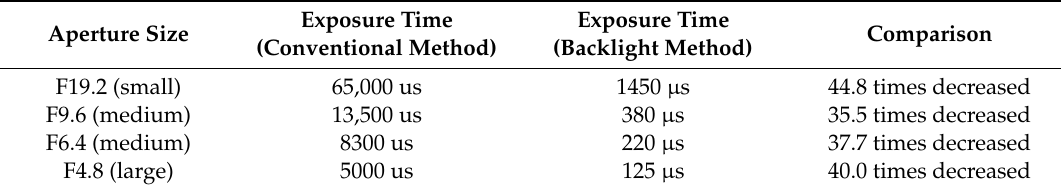
Figure 4. Experimental setup of enhanced t -DGS and its measurement results. ( a ) Experimental setup and captured speckle images; ( b ) measured stress gradient contours at tensile load of 150 and 300 N. Table 1. Exposure time of di ff erent aperture sizes and di ff erent lighting methods.